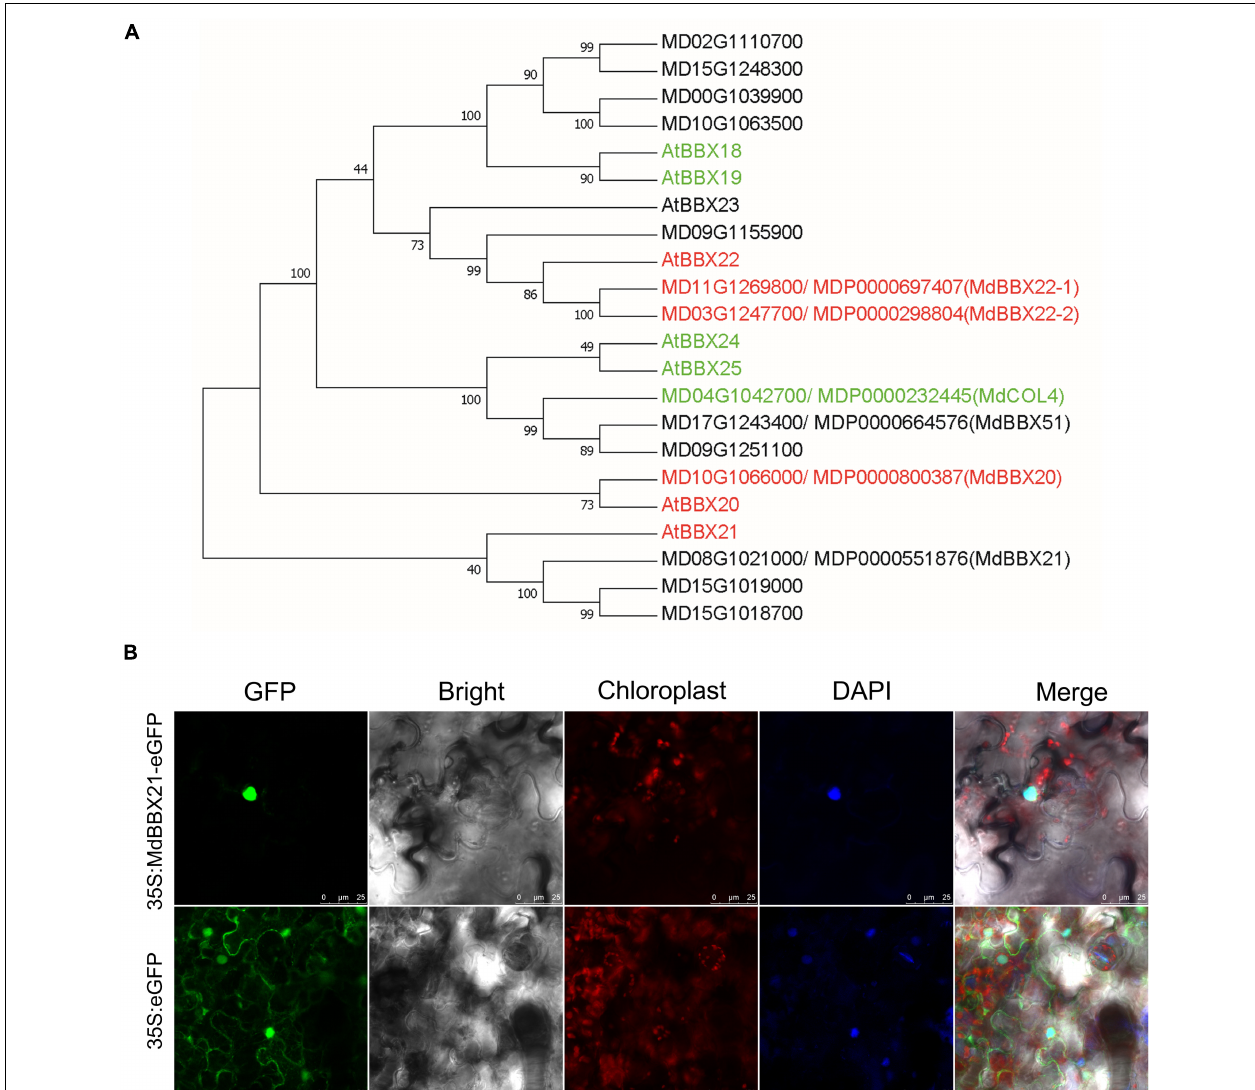
FIGURE 3 | Characterization of MdBBX21 . (A) Phylogenetic relationship of apple and Arabidopsis subfamily IV members. The red and green genes represent positive and negative regulators related to light signaling, respectively. The phylogenetic tree was constructed using the neighbor-joining method by MEGA 7.0. The bootstrap values of 1000 replicates were calculated at each node. (B) Subcellular localization of MdBBX21 expressed in tobacco leaf